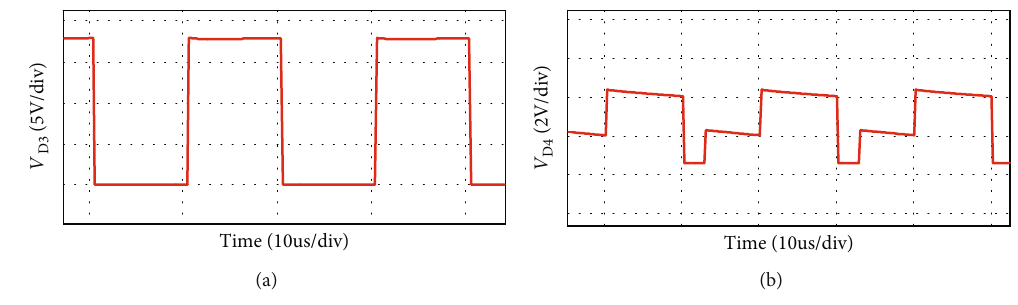
Figure 14: Diode D